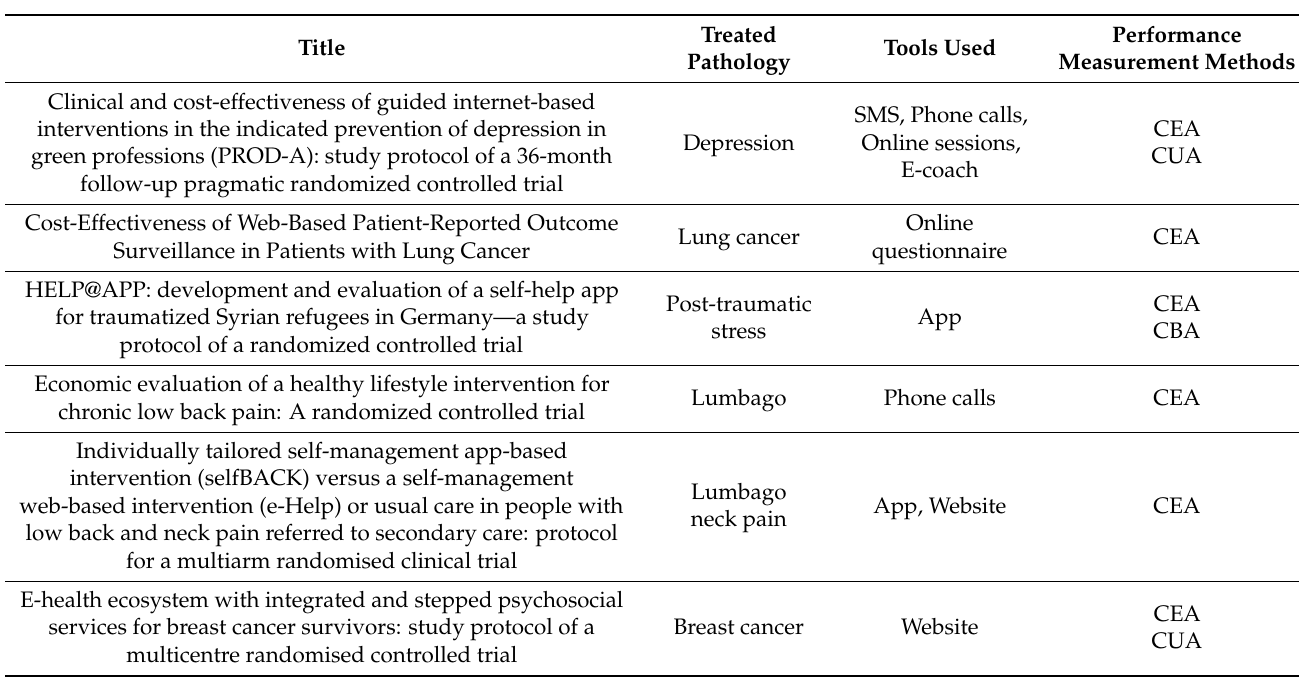
Table 4. Possible relationships among the treated pathologies, tools, and performance measurement methods used. Title